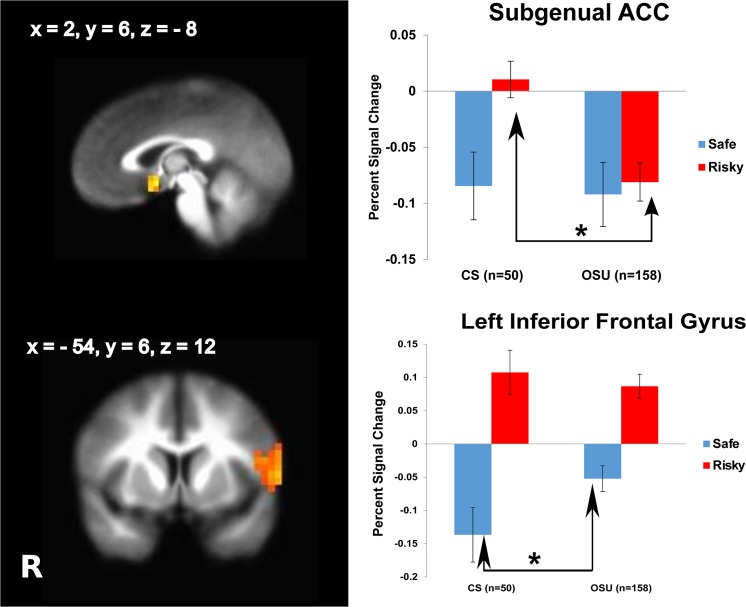
Occasional stimulant users (OSU) present lower subgenual anterior cingulate cortex (sgACC) recruitment during risky decisions and less deactivation of inferior frontal gyrus to safe decisions than comparison subjects (CS).LME analysis results, group by decision (risky vs. safe) interaction (n = 208). Cluster significance of p < .05 corrected for multiple comparisons (voxel-wise probability: p < .05). R indicates right, error bars represent standard errors, asterisk = sign. at p = 0.05.